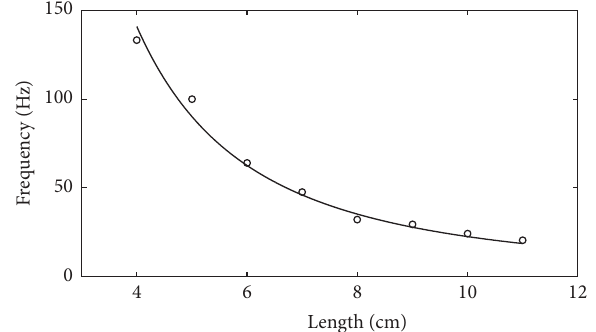
Figure 5: Change of the oscillation frequency with respect to the length of the PZT cantilever.